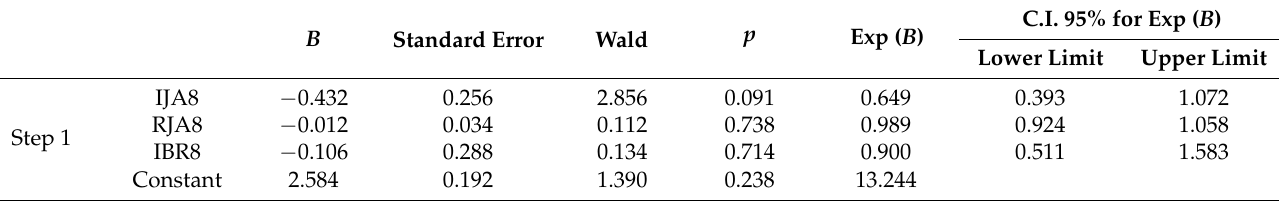
Table 3. Results for multiple logistic regression analysis (8